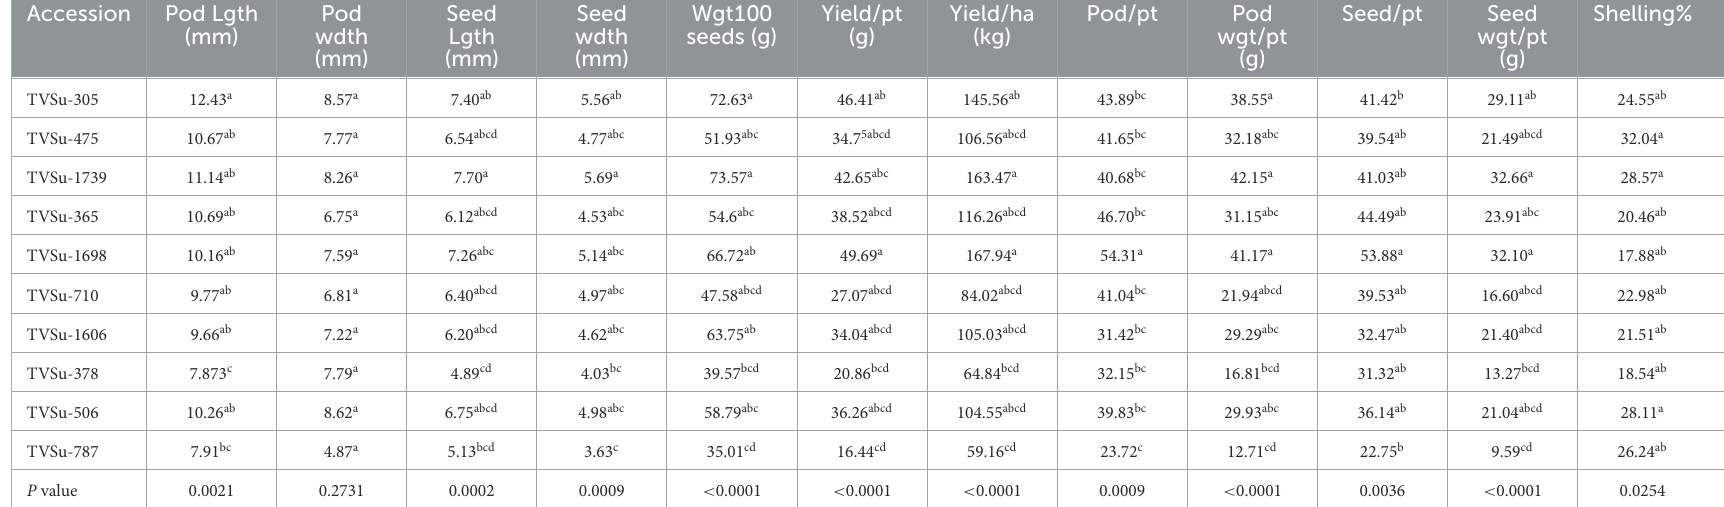
TABLE 6 Effects of treatments on yield and yield components of BGN accessions in Ibadan and Ikenne in 2020 cropping season.